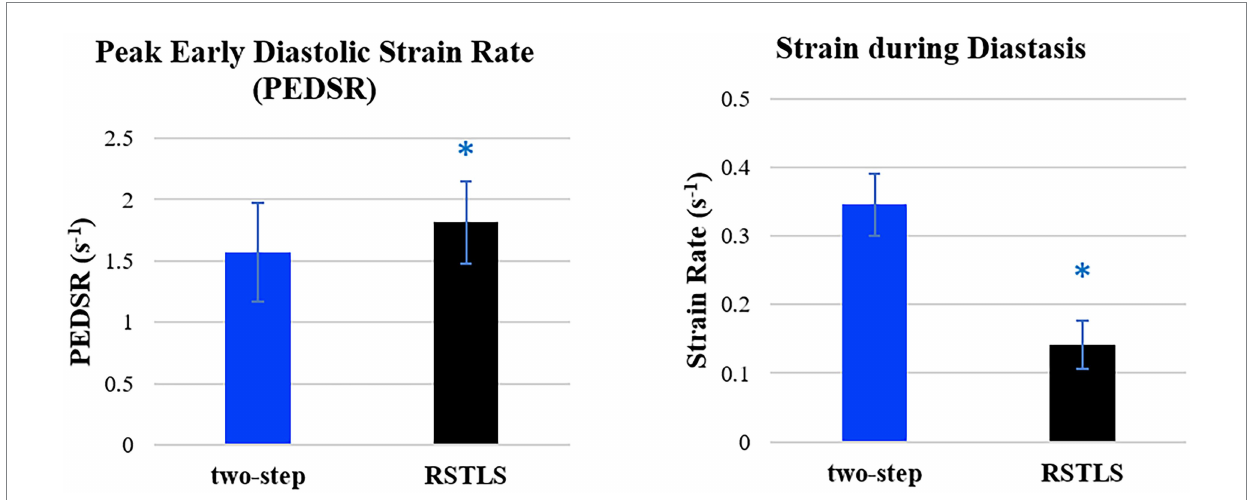
FIGURE 5 Comparison of global peak early diastolic strain rate and strain rate during diastasis for healthy subjects. The graphs are plotted based on 182 slices from 71 volunteers. Error bars represent standard deviations. * p <